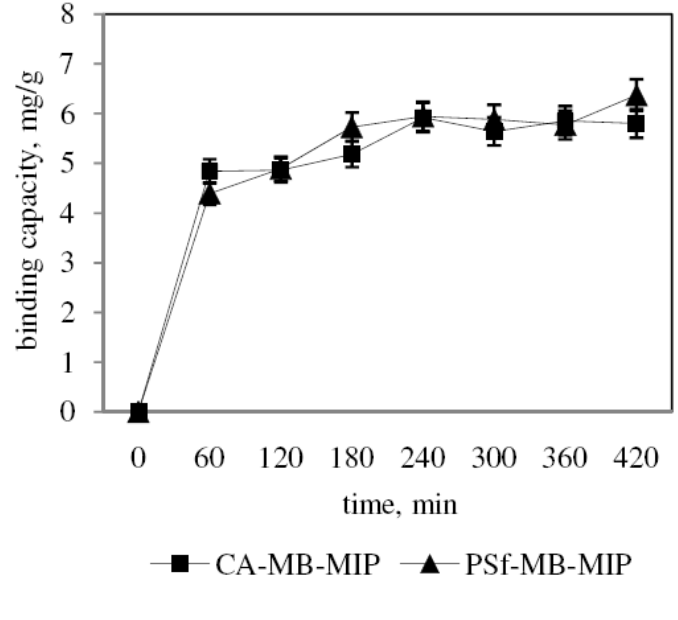
Figure 7. Kinetic study for sorption of MB on CA-MB-MIP membrane and PSf-MB-MIP